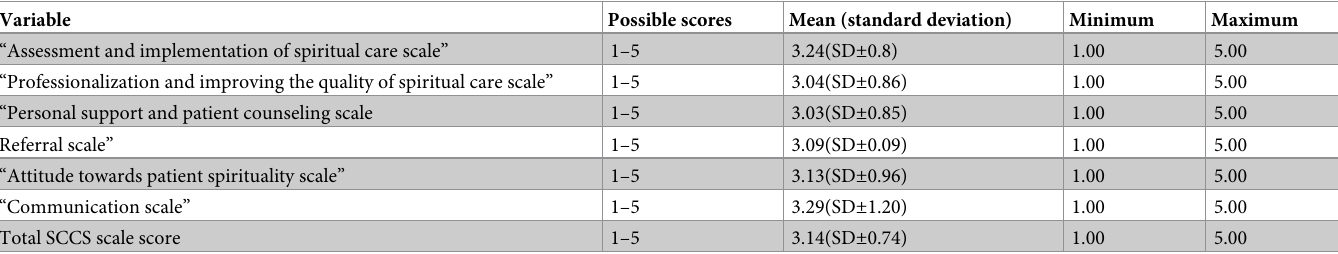
Table 3. The spiritual care competence of nurses at selected public hospitals in southwest Ethiopia in 2021 (n = 367). Variable